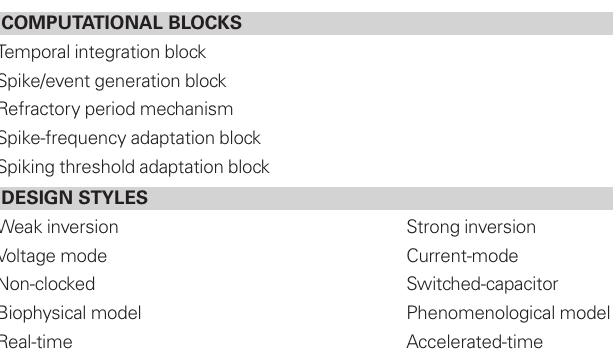
Table 1 | Main SiN computational blocks, and circuit design